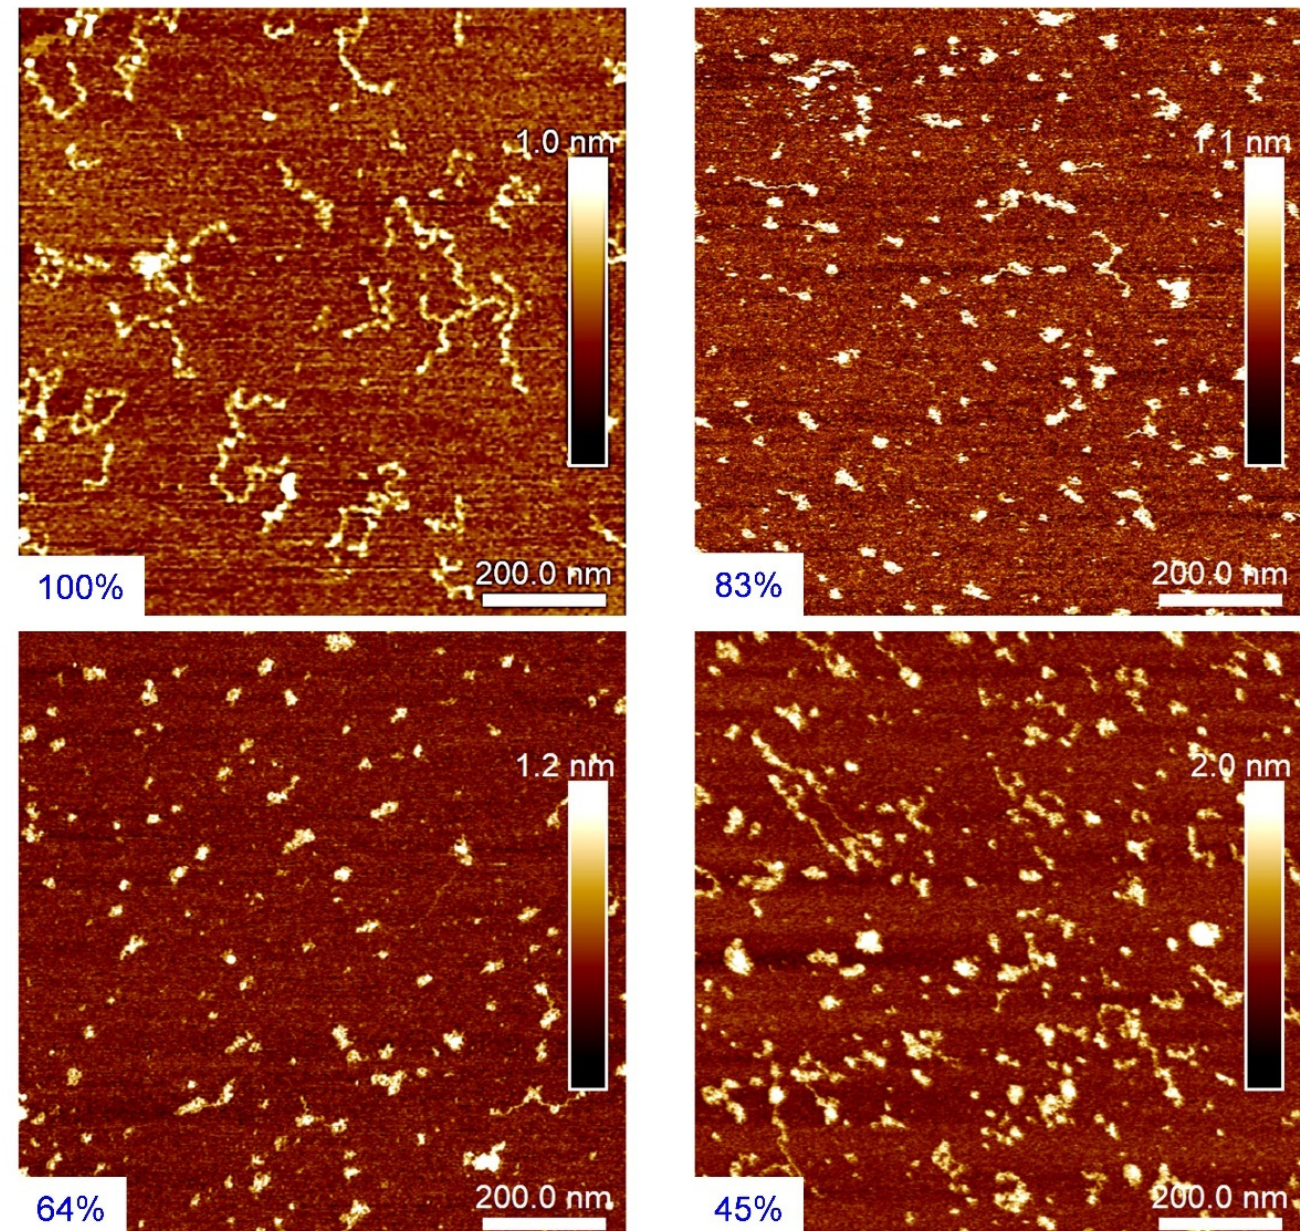
Figure 4 . AFM images of PSS100%, PSS83%, PSS64%, and PSS45% chains on molecularly smooth MgCl 2 -treated mica surfaces.